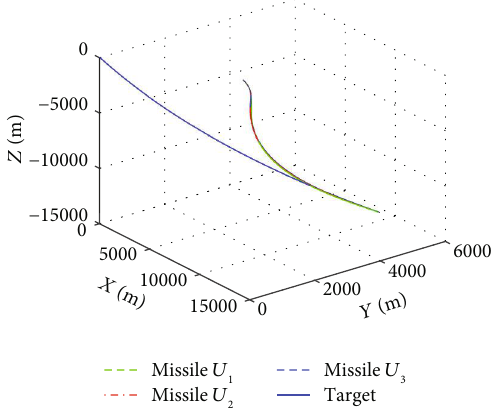
Figure 31: Relative trajectories.